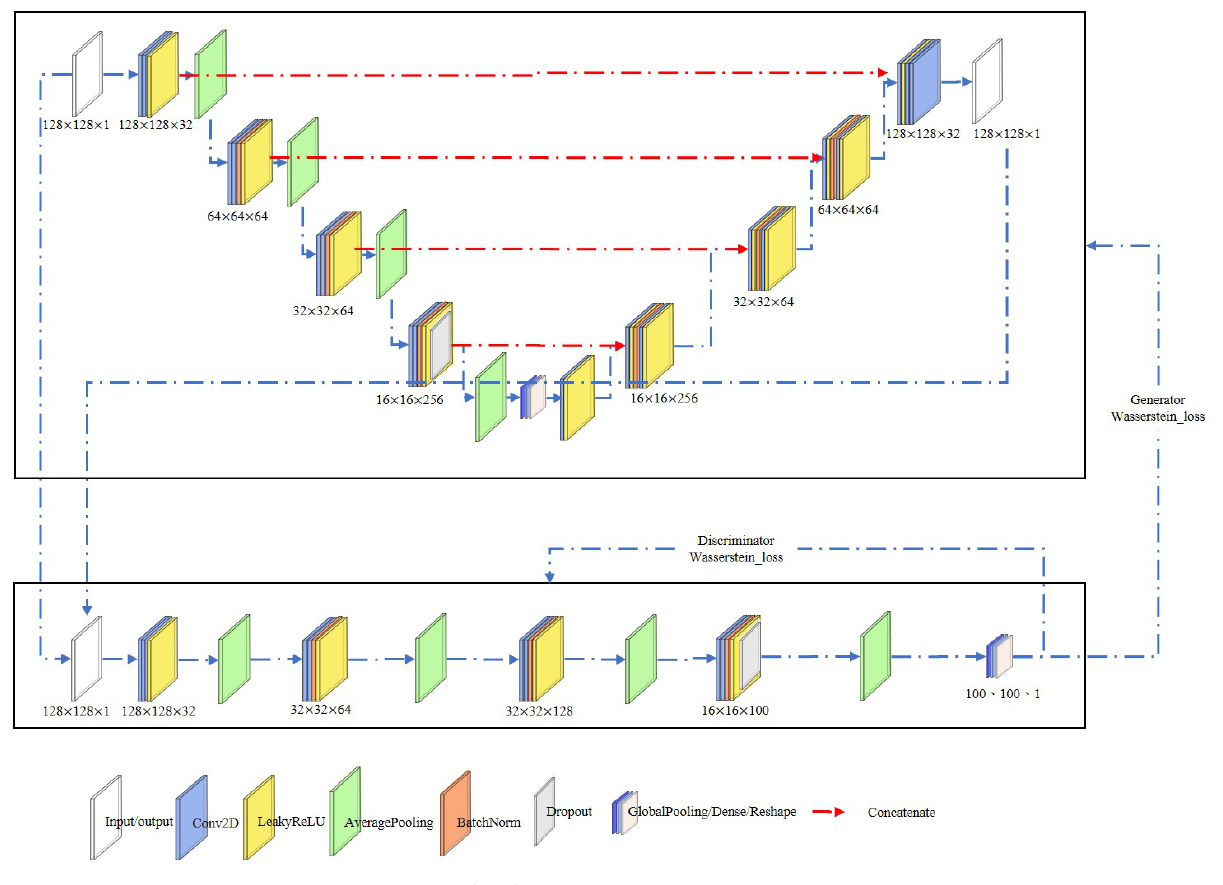
Figure 3. Proposed